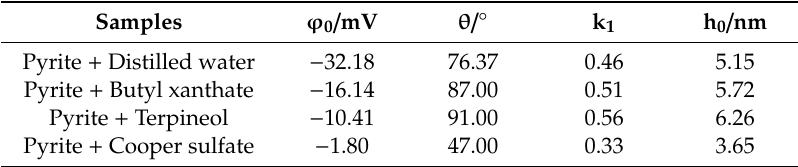
Table 4. Results of surface contact angle and zeta potential of